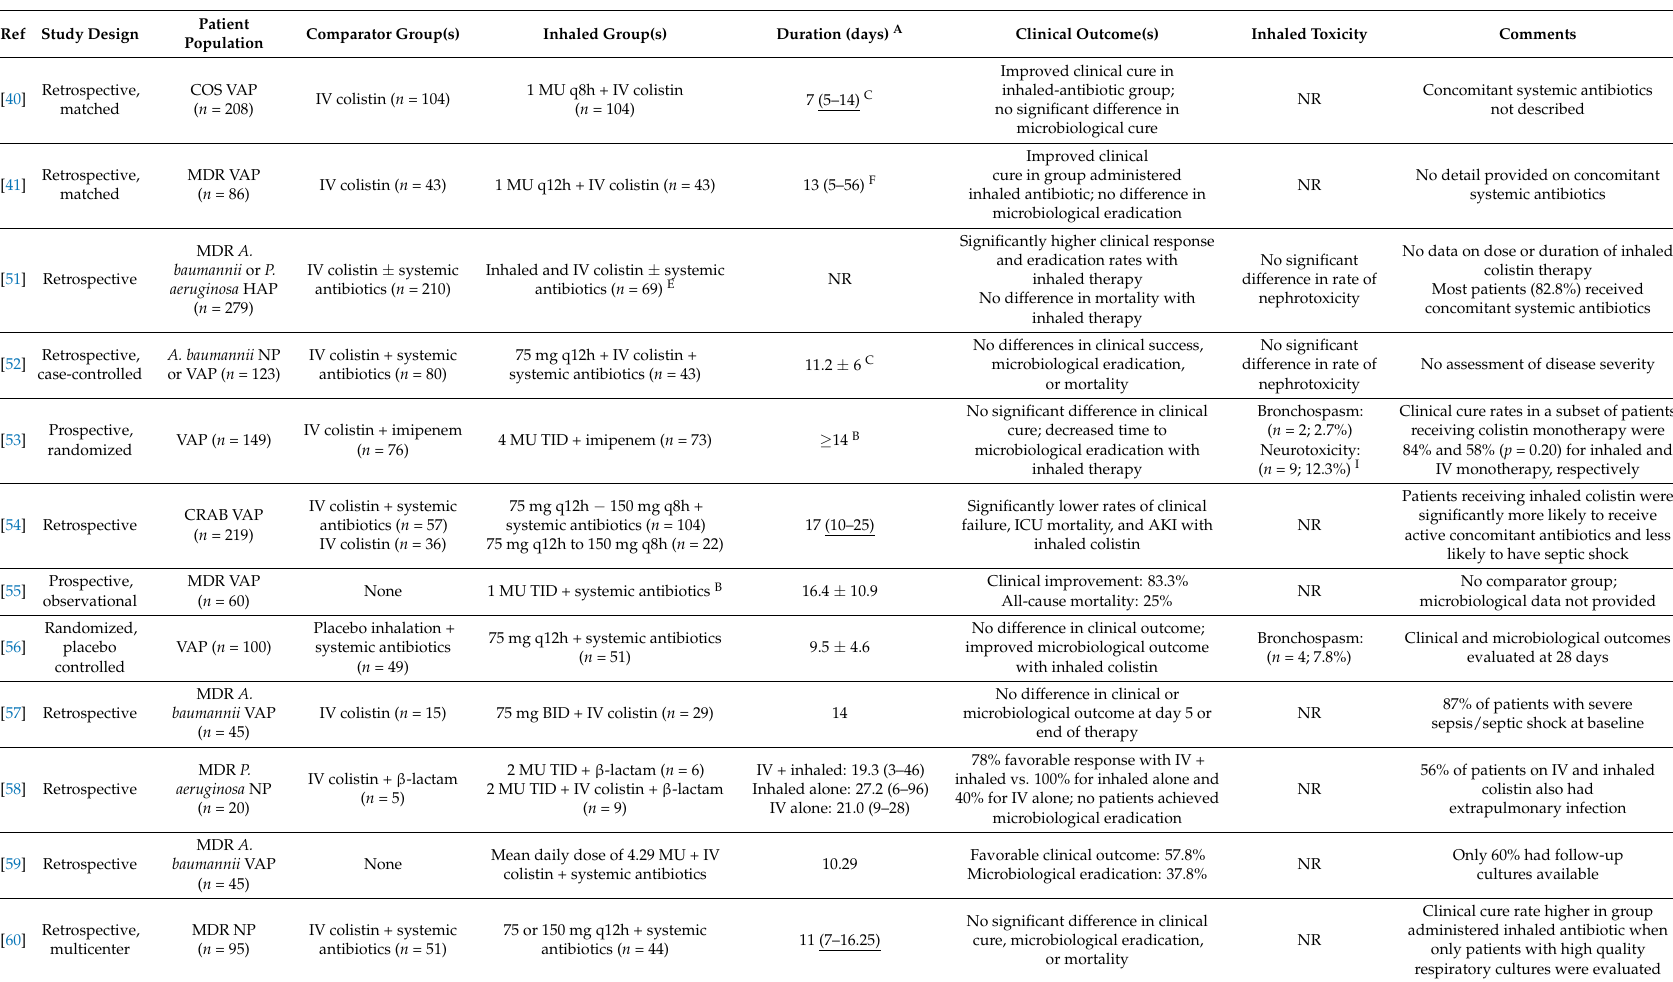
Table 2. Summary of studies evaluating inhaled colistin as adjunctive therapy to IV colistin for Gram-negative nosocomial pneumonia and/or ventilator-associated